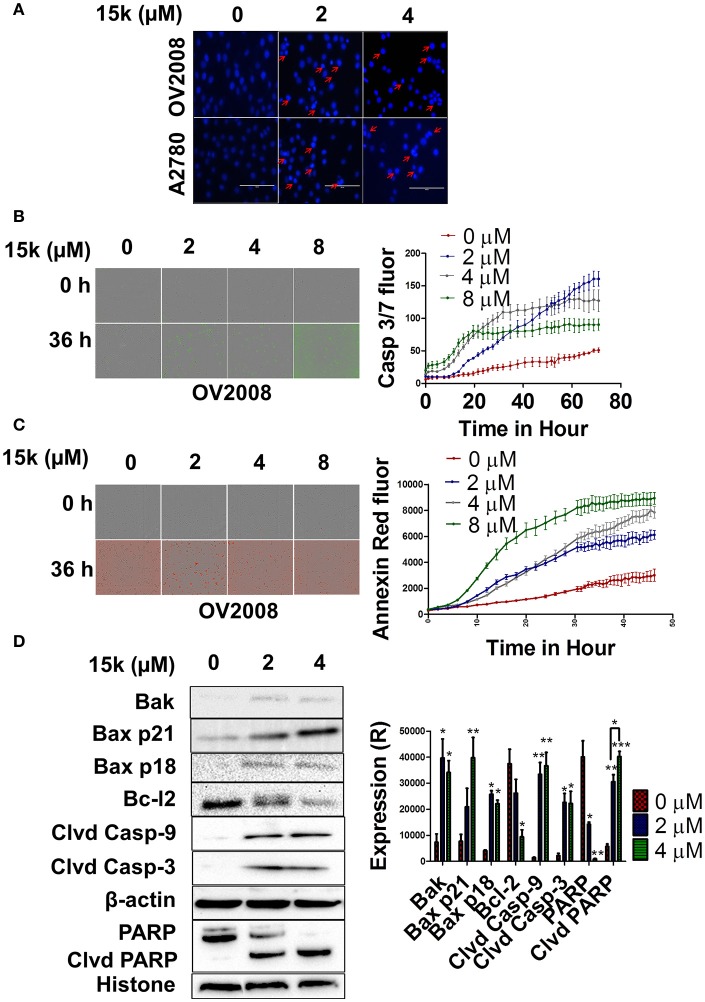
15k induces apoptosis through the intrinsic apoptotic pathway in OV2008 cells; (A) The nuclear fragmentation and apoptotic chromatin condensation (red arrows) due to 15k (0, 2, and 4 μM) at 40x. (B,C) A real-time quantification of apoptosis after incubation of cells with 15k (0, 2, 4, and 8 μM), using two IncuCyte fluorescent dyes (caspase 3/7 reagent and Annexin V red, respectively), in OV2008 cells. The caspase 3/7 reagent yields a green fluorescence and Annexin V produces red fluorescence. The pictures illustrate the fluorescence (fluor) level of the two reagents at the 0 and 36 h time points. In addition, the detailed results are shown in the time line curves next to the pictures. (D) The Western blot expression levels for the proteins Bak, Bax p21, Bax p18, Bcl-2 cleaved caspase-9, cleaved caspase-3, nuclear PARP and nuclear cleaved PARP following incubation with 15k (0, 2, or 4 μM), where Clvd is for cleaved, Casp for caspase. β-actin was used as a cytosolic reference protein and histone as a reference for nuclear proteins. A histogram summarizing the result is shown next to the Western blots where (R) is for relative. The results are presented as the means ± SEM. *p < 0.05, **p < 0.01, ***p < 0.001 vs. the control group.